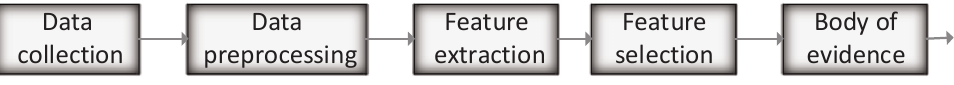
Figure 2. Working process of